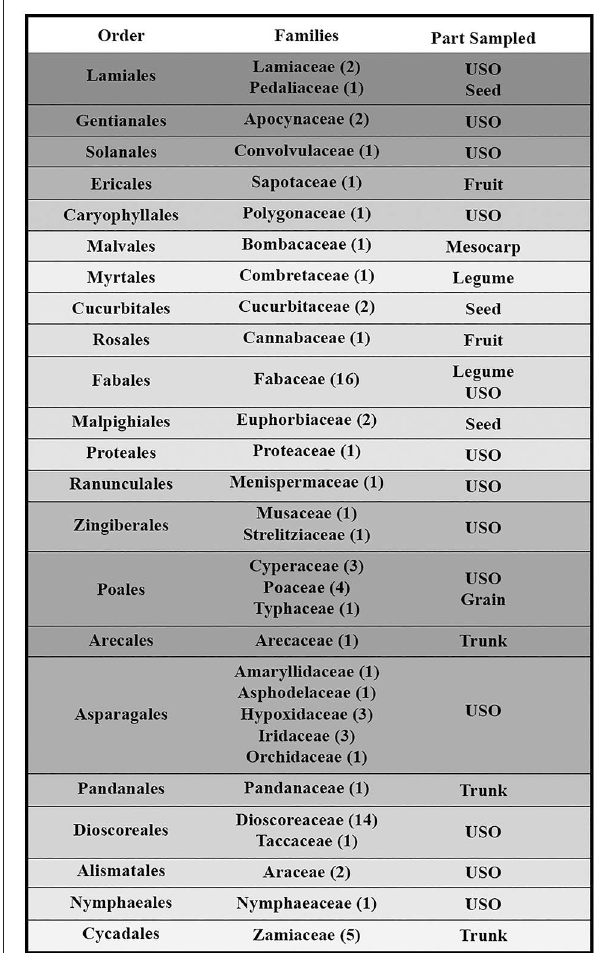
FIGURE 1 | Family phylogenetic grouping of studied samples classified from derived to primitive (top to bottom). USO, Underground Storage Organ.